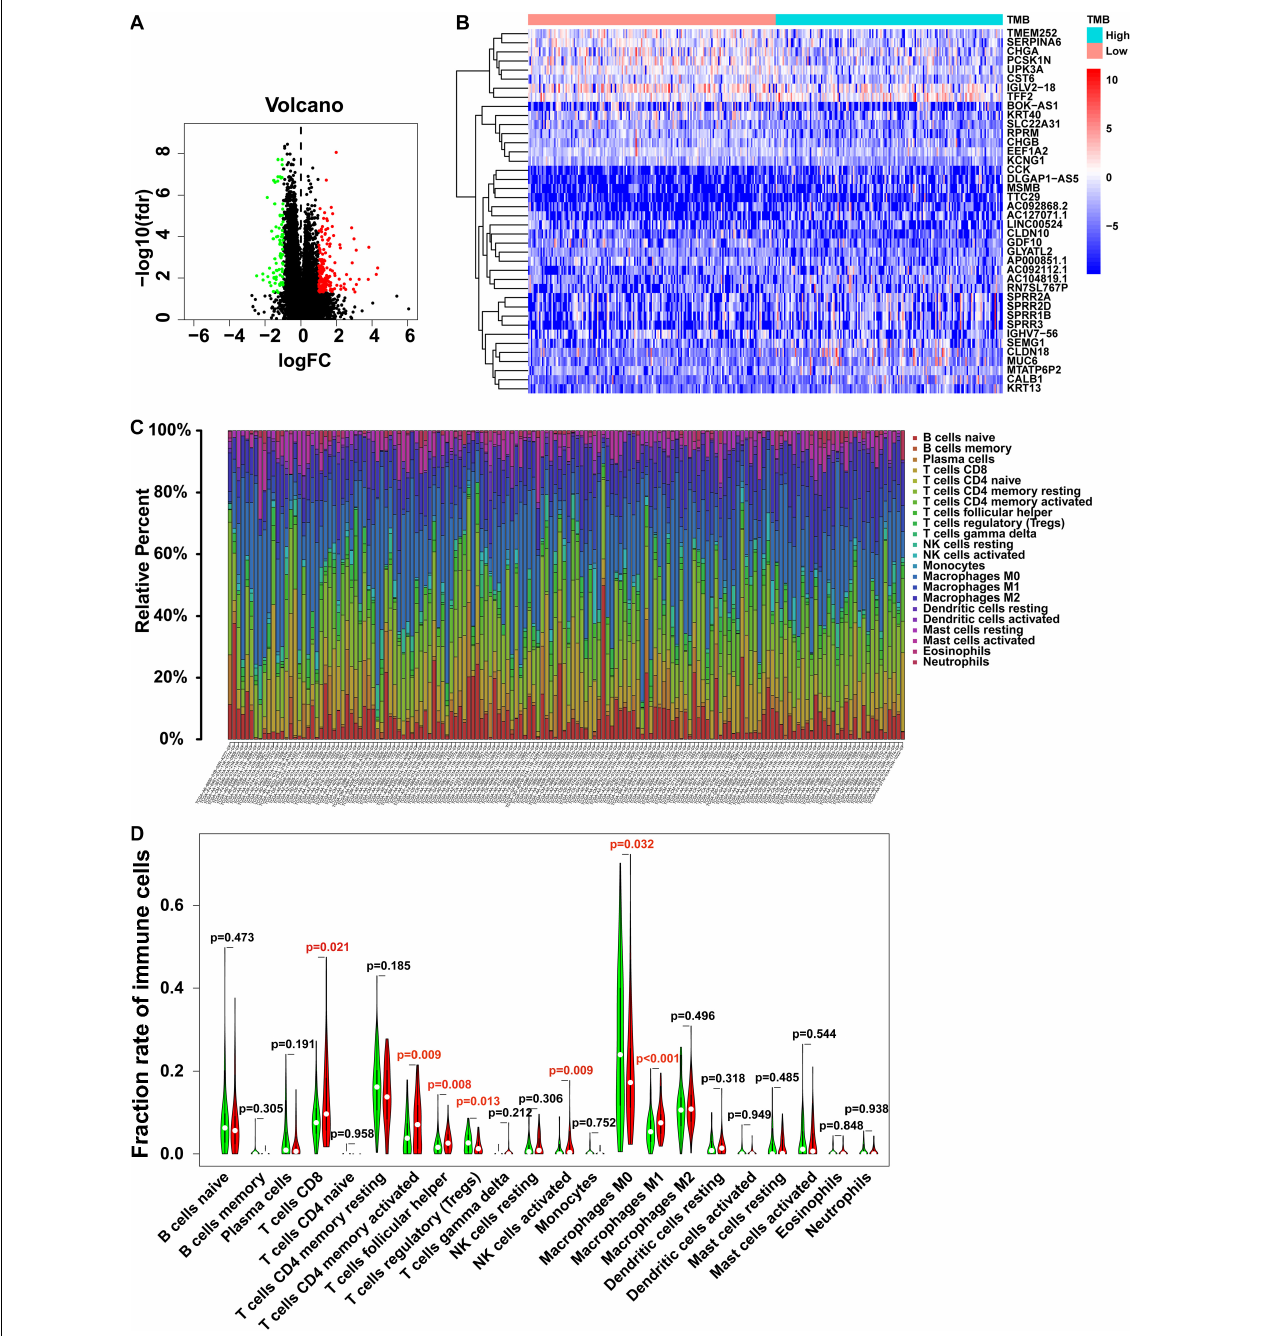
FIGURE 4 | Gene expression profiles and immunocytes fraction between low- and high-TMB groups. (A) Volcano plot shows the DEGs in colon cancer. Red represents the high TMB group, and green represents the low TMB group. (B) Top 40 DEGs from low- and high-TMB groups are shown in the heatmap. (C) The fraction of 22 immunocyte subtypes of each colon cancer sample is represented by different colors listed on the right panel of the bar plot. (D) The violin plot shows the differences of infiltrated immunocyte subtypes between low- (green) and high-TMB (red) groups. The statistical significance is represented in red with P -value < 0.05. DEGs, differentially expressed